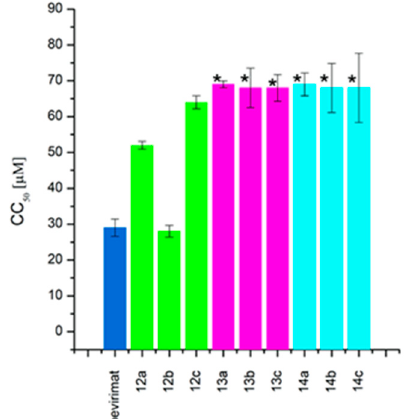
Figure 2. Cytotoxicity (CC 50 ) of 3-carboxyacylbetulinic acids divided into groups of corresponding phosphorus derivatives (30-phosphate: 12a – c ; 29-phosphonate: 13a – c ; 30-phosphonate: 14a – c ) and